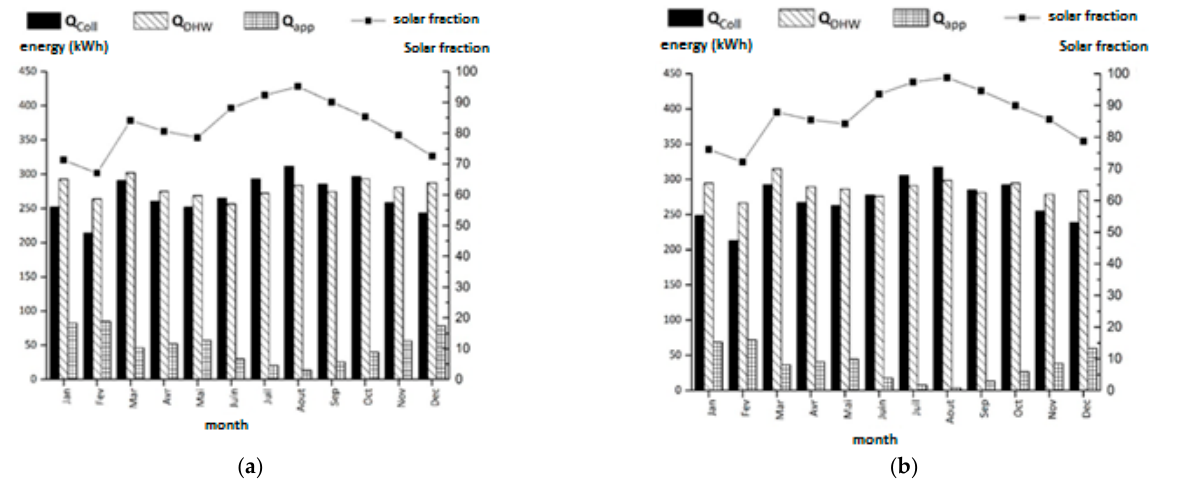
Figure 9. ( a ) Flat plate collector, ( b ) evacuated tube collector (standard demand).